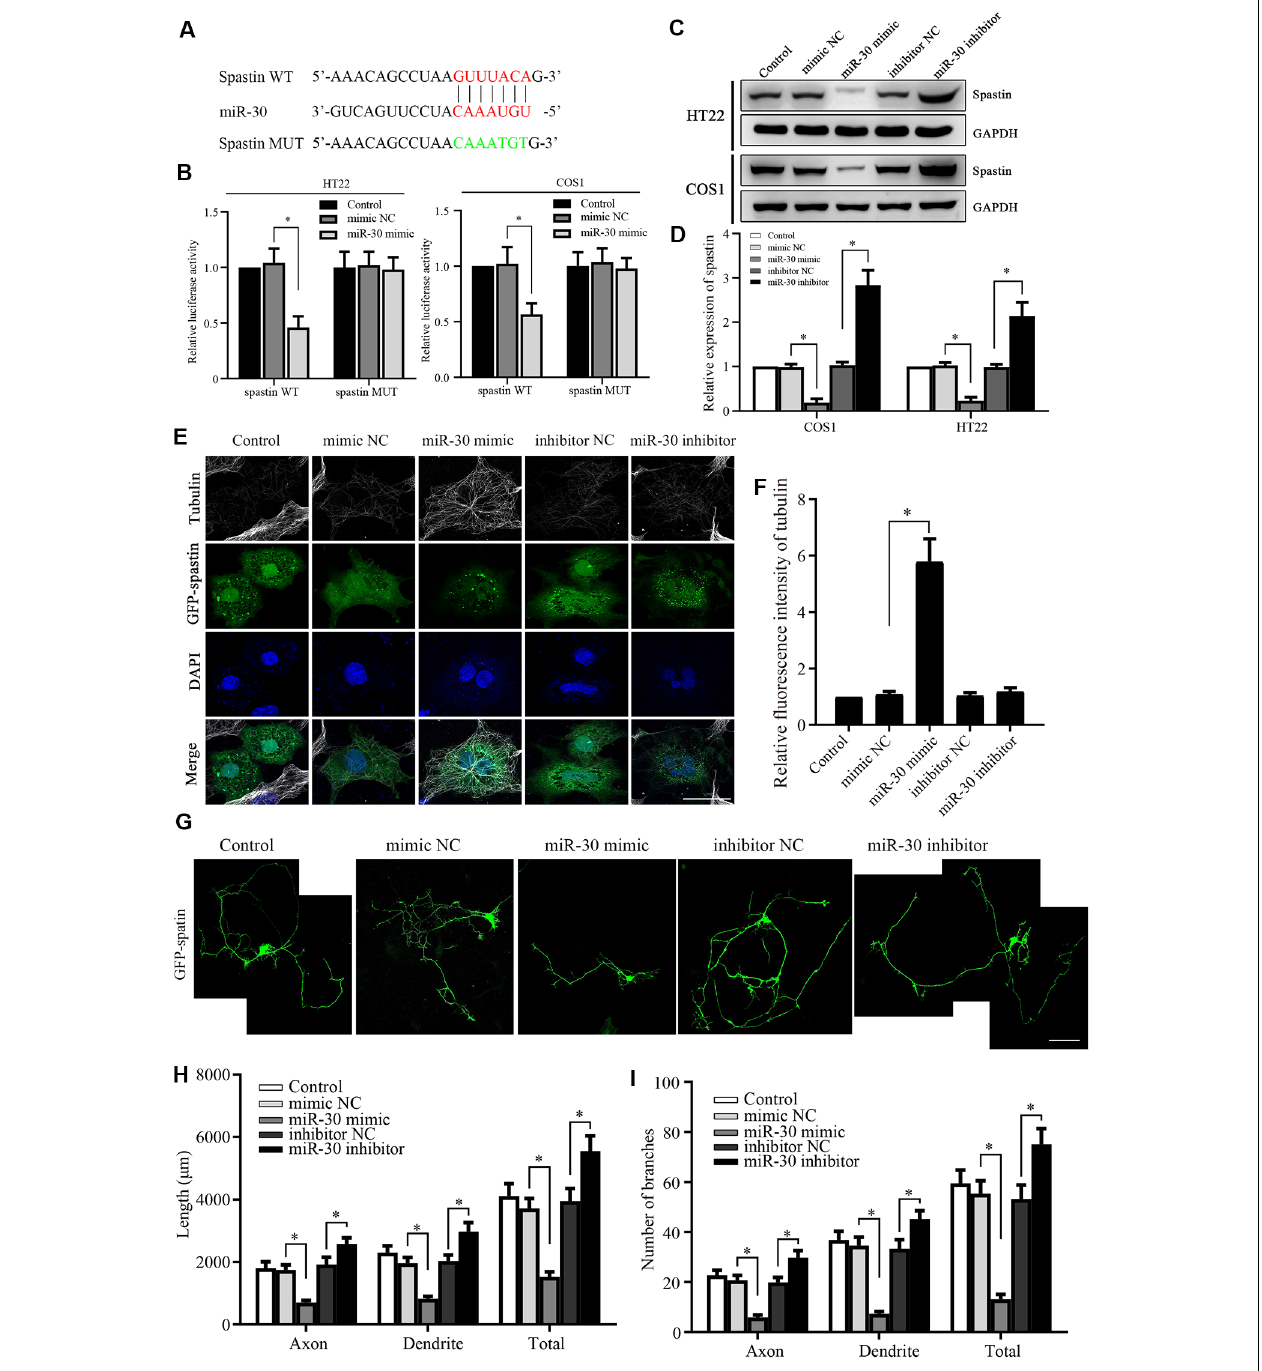
FIGURE 2 | Spastin is targeted by miR-30 to regulate microtubule dynamics and neurite outgrowth. (A) Luciferase reporter plasmids of spastin WT and MUT were constructed to determine the effect of miR-30. The targeted and mutant sequences are shown. (B) Spastin luciferase reporter plasmids were co-transfected with miR-30 mimic or control. The luciferase activity was measured in HT22 and COS1 cells ( n = 3). (C) Protein expression levels of spastin were determined by western blotting of extracts from HT22 and COS1 cells transfected with miR-30 mimics or controls ( n = 3) and relative expression levels of spastin vs. GAPDH were quantified (D) . (E) The mimic or inhibitor of miR-30 was co-transfected together with the GFP-spastin plasmid into COS1 cells, which were then subjected to immunofluorescent antibody staining for tubulin (white) and GFP (green). Nuclei are stained with DAPI (blue); Scale bar, 25 µ m. (F) The relative fluorescence intensities of tubulin in COS1 cells were quantified ( n = 3; cell number > 50/group of each repeat). (G) The mimics or inhibitor of miR-30 were co-transfected with the GFP-spastin plasmid into DIV3 hippocampal neurons for 48 h, and the neurons were immunostained to assess morphology; Scale bar, 50 µ m. The lengths (H) and the number of branches (I) of neurites were measured ( n = 3; neuron number > 30/group of each experimental repeat). ∗ P < 0.05.